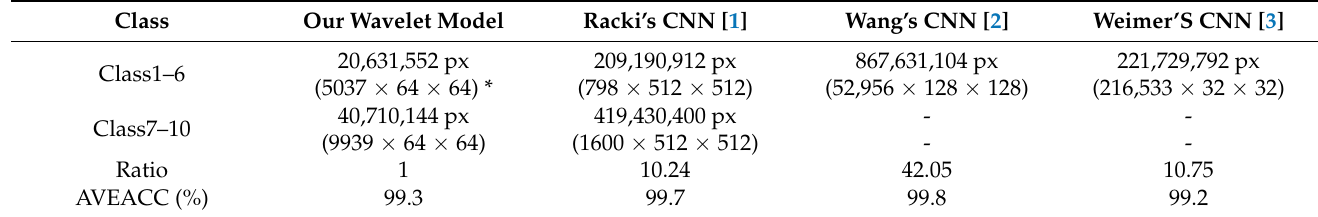
Table 4. The number of pixels in each training set between our method and others.